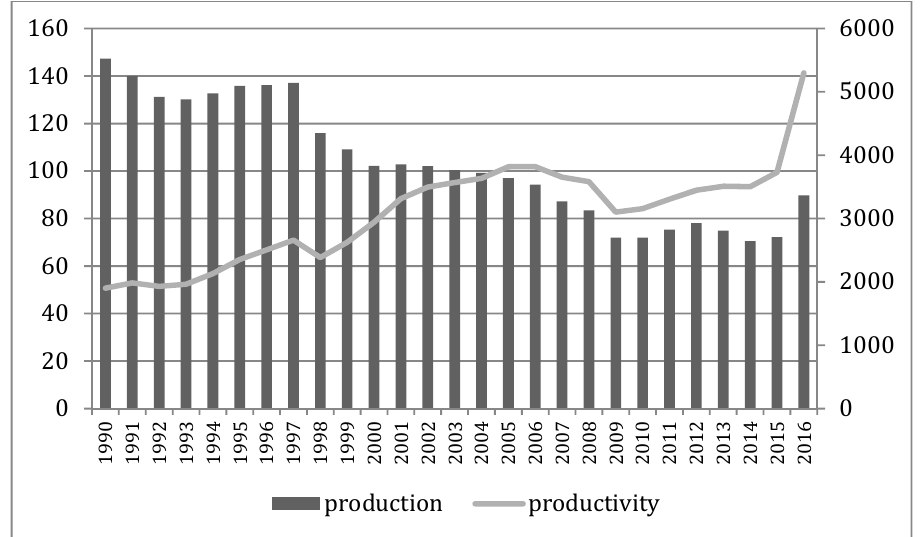
Figure 2. Hard coal production [in millions of tonnes] and efficiency [daily in tonnes per employee] in Poland in the years 1990–2016.